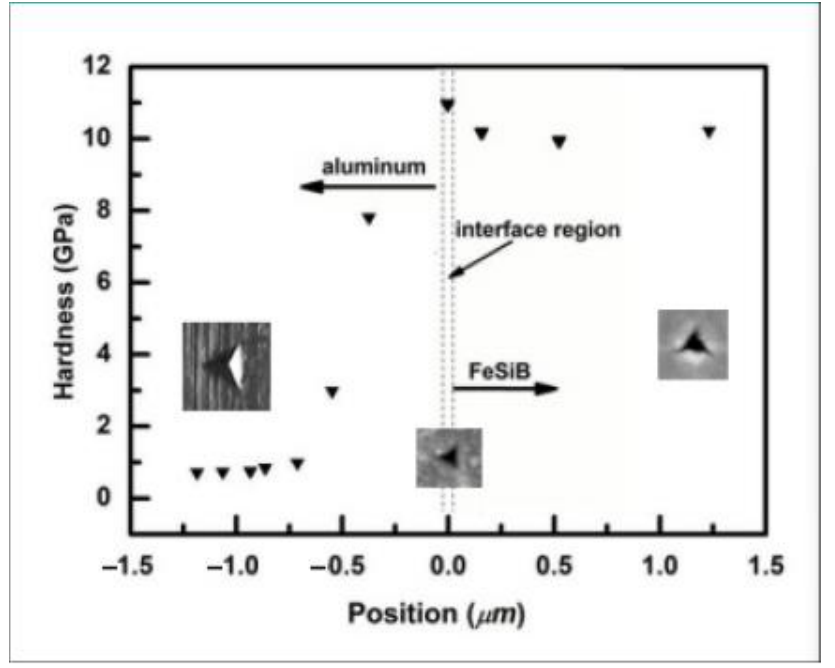
Figure 4. The hardness of the alloy around the bonding interface processed by HPT under 1.1 GPa at 4 torsion rounds. 4 torsion